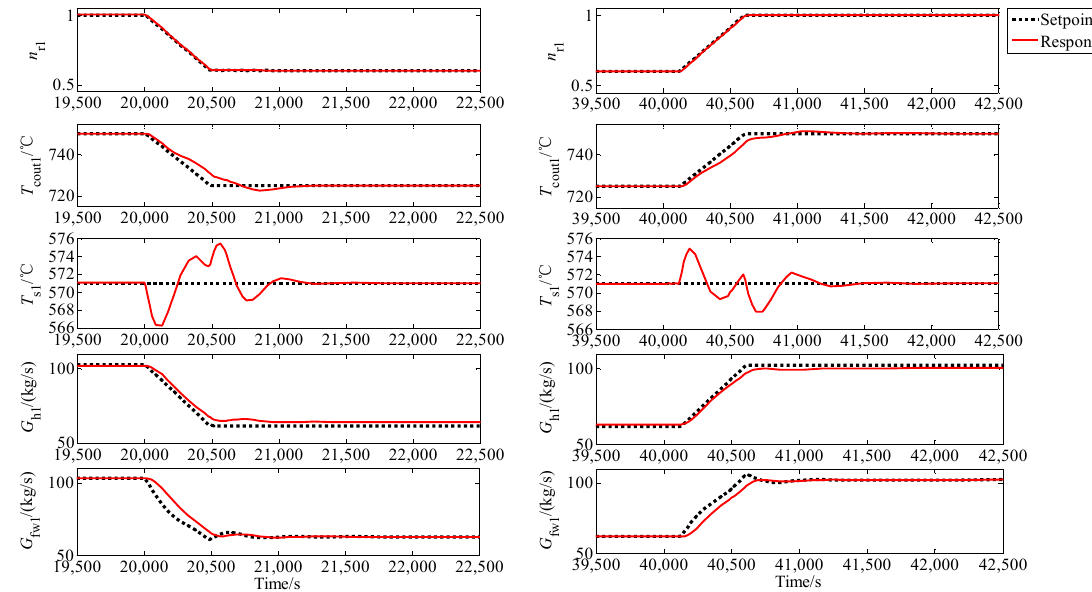
Figure 10. Responses of 1# MHTGR-based OTSSS, n r1 : normalized nuclear power, T cout1 : reactor outlet helium temperature, T s1 : live steam temperature, G h1 : primary helium flowrate, G fw1 : secondary feedwater flowrate.